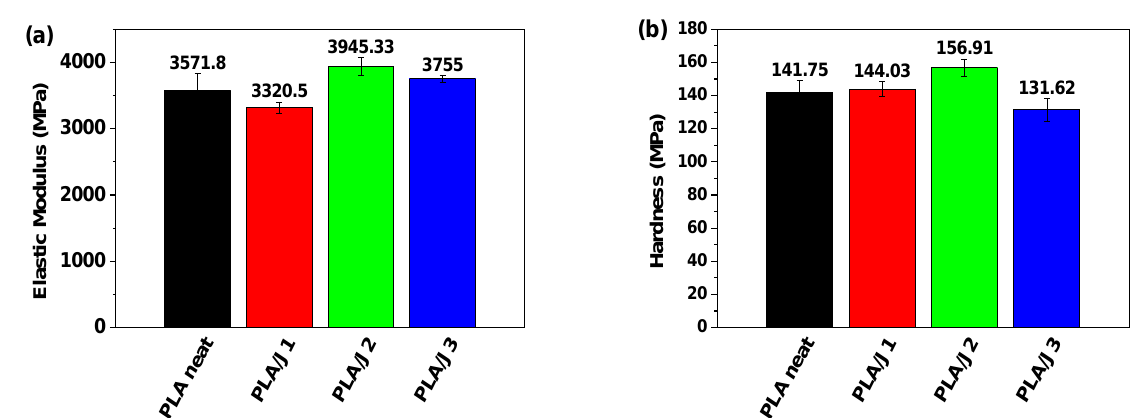
Figure 6. Comparison of ( a ) elastic modulus and ( b ) hardness.of neat PLA and PLA/J filaments. Figure 7a presents the stress–strain curves of PLA and PLA/J specimens